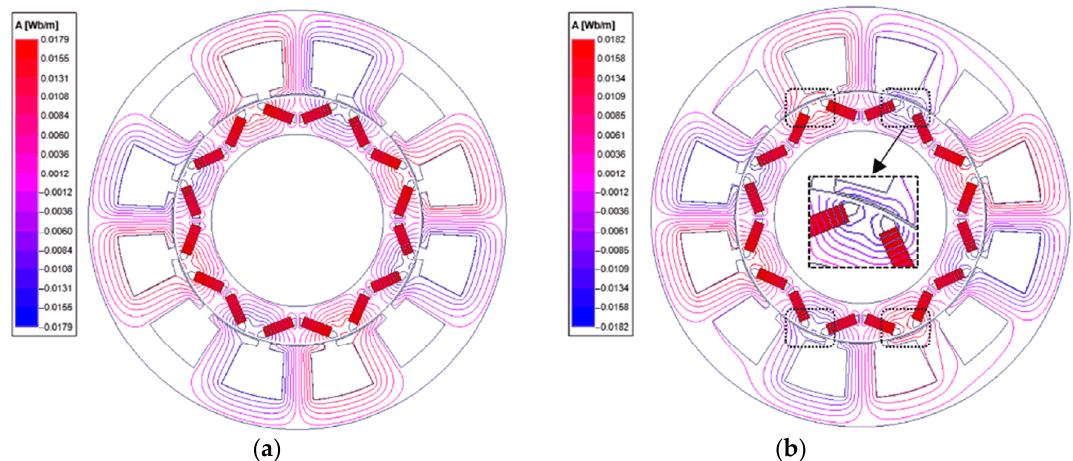
Figure 5. The no-load magnetic field distribution for IPM machine: ( a ) the normal slot opening, ( b ) the IPU slot-opening shift.